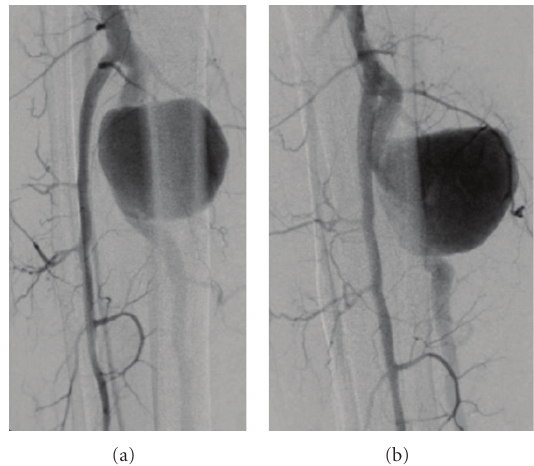
Figure 2: Posterior tibial artery aneurysm detected by angiography scan.